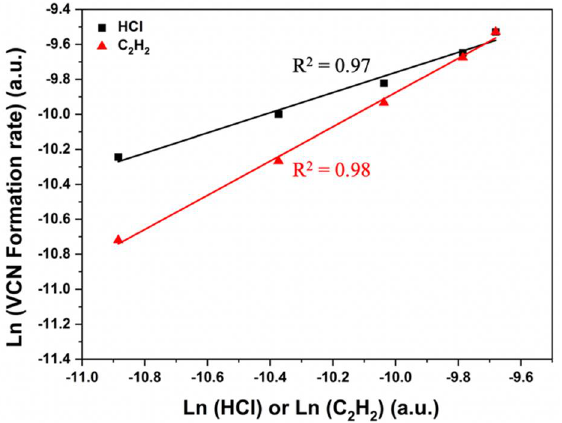
Figure 4. Changes in the natural logarithm of the VCM formation rate with the natural logarithm of the reactant concentrations. The SDs for the black and red data are 0.28 and 0.47, respectively.